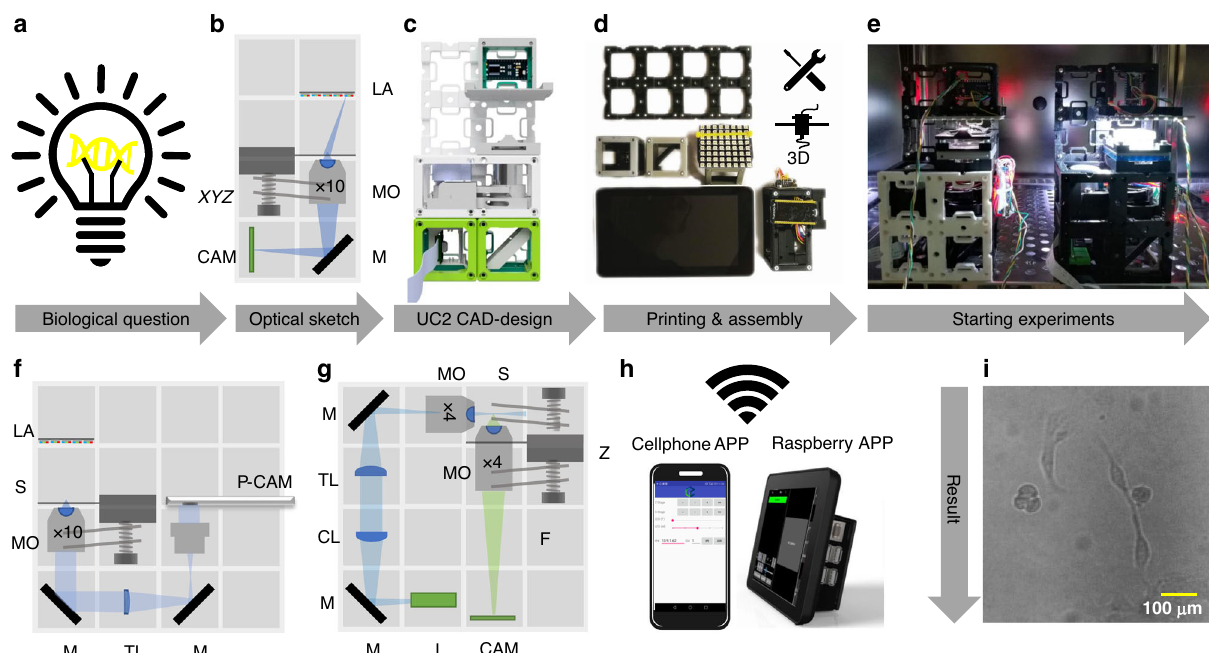
Fig. 2 Rapid Prototyping using UC2. Common work fl ow to build a UC2 application: ( a ) Starting with a biological question/idea in need of an imaging device drafted in ( b ) (inverted incubator microscope) and transferred using UC2 components from the CAD library in ( c ). After printing and assembling it ( d ) the device will be placed in its working environment (e.g. incubator) ( e ) ready to acquire long-term image series of e.g. MDCK cells visualized in ( i ) and Supplementary Video 6. Remote-control is granted using “ smart components ” (e.g. cellphone, Raspberry Pi) in ( h ). Reusing components allows the conversion into a cellphone-microscope ( f ) or light sheet microscope ( g ) within minutes (see Supplementary Video 5) and Supplementary Notes 7.8). CL: cylindrical lens, TL: tube lens, L: Laser, LA: LED-array, M: Mirror, MO: Microscope Objective, P-CAM: Detector (smartphone or Raspberry Pi), S: sample positioning stage, F: emission fi lter, Z: focusing